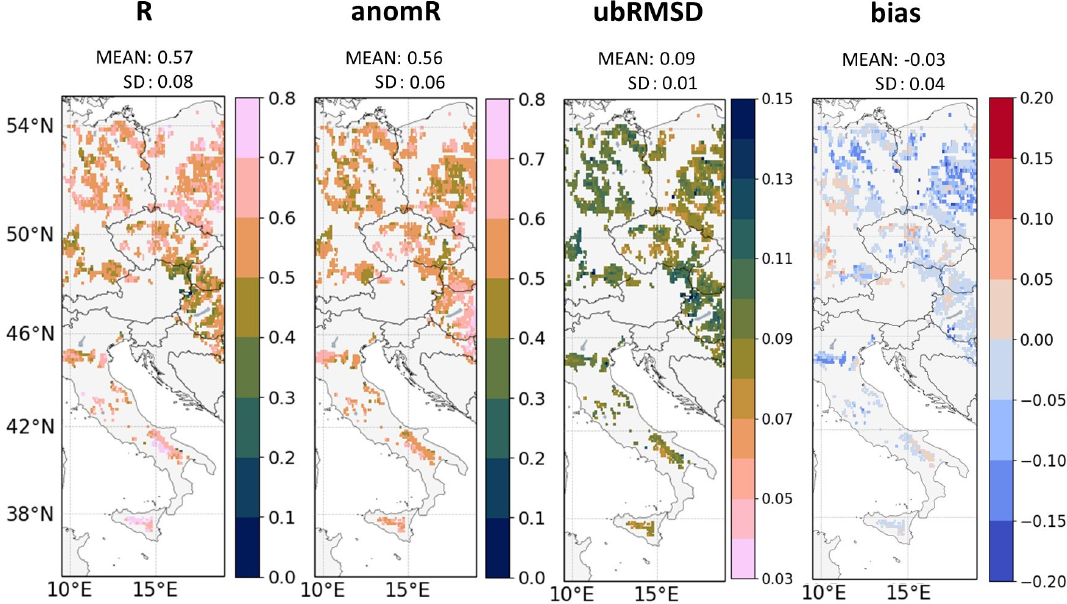
Figure 7. Same as Fig. 6b, but after aggregation of the CGLS-SSM data to the 9km EASEv2 grid and spatial cross-masking with SMAP-SSM